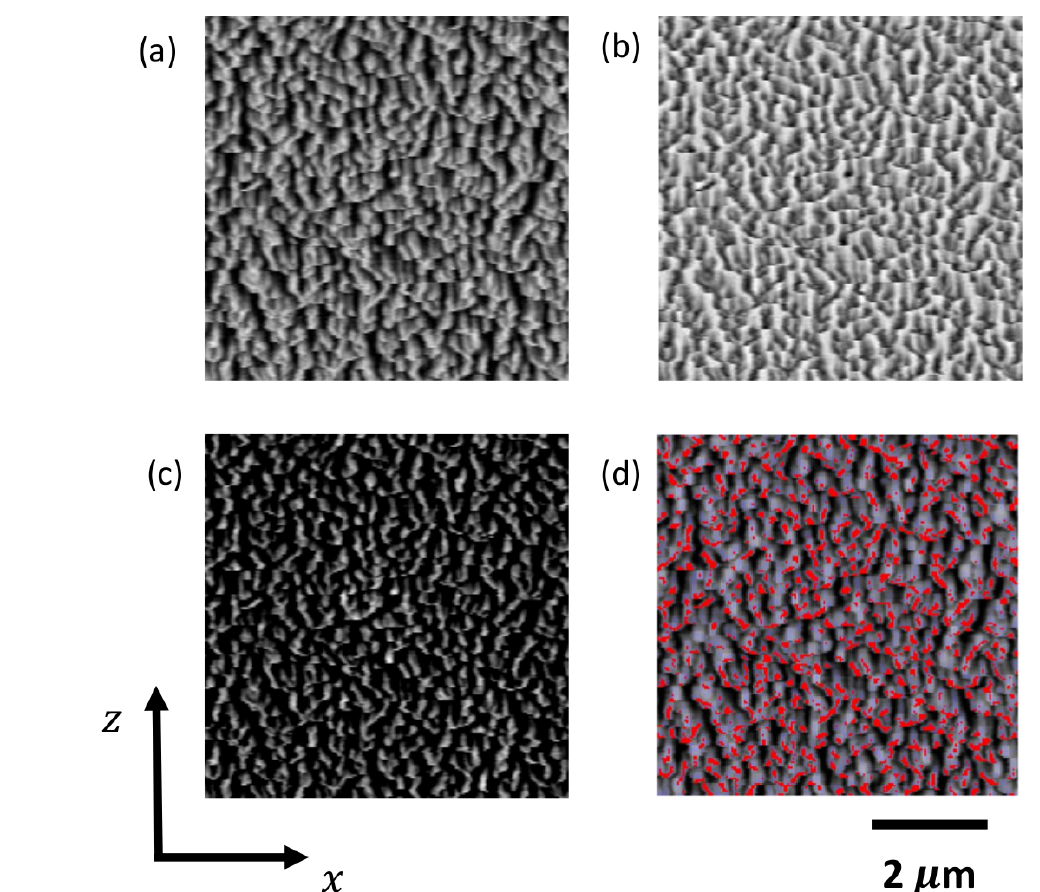
Figure 5. Ta85 xz profiles: (a) the original stack, (b) after difference of Gaussians, (c) after the subtraction of fill-holes, and (d) the overlapped image (red represents the matrix phase, and blue represents the extracted shine-through